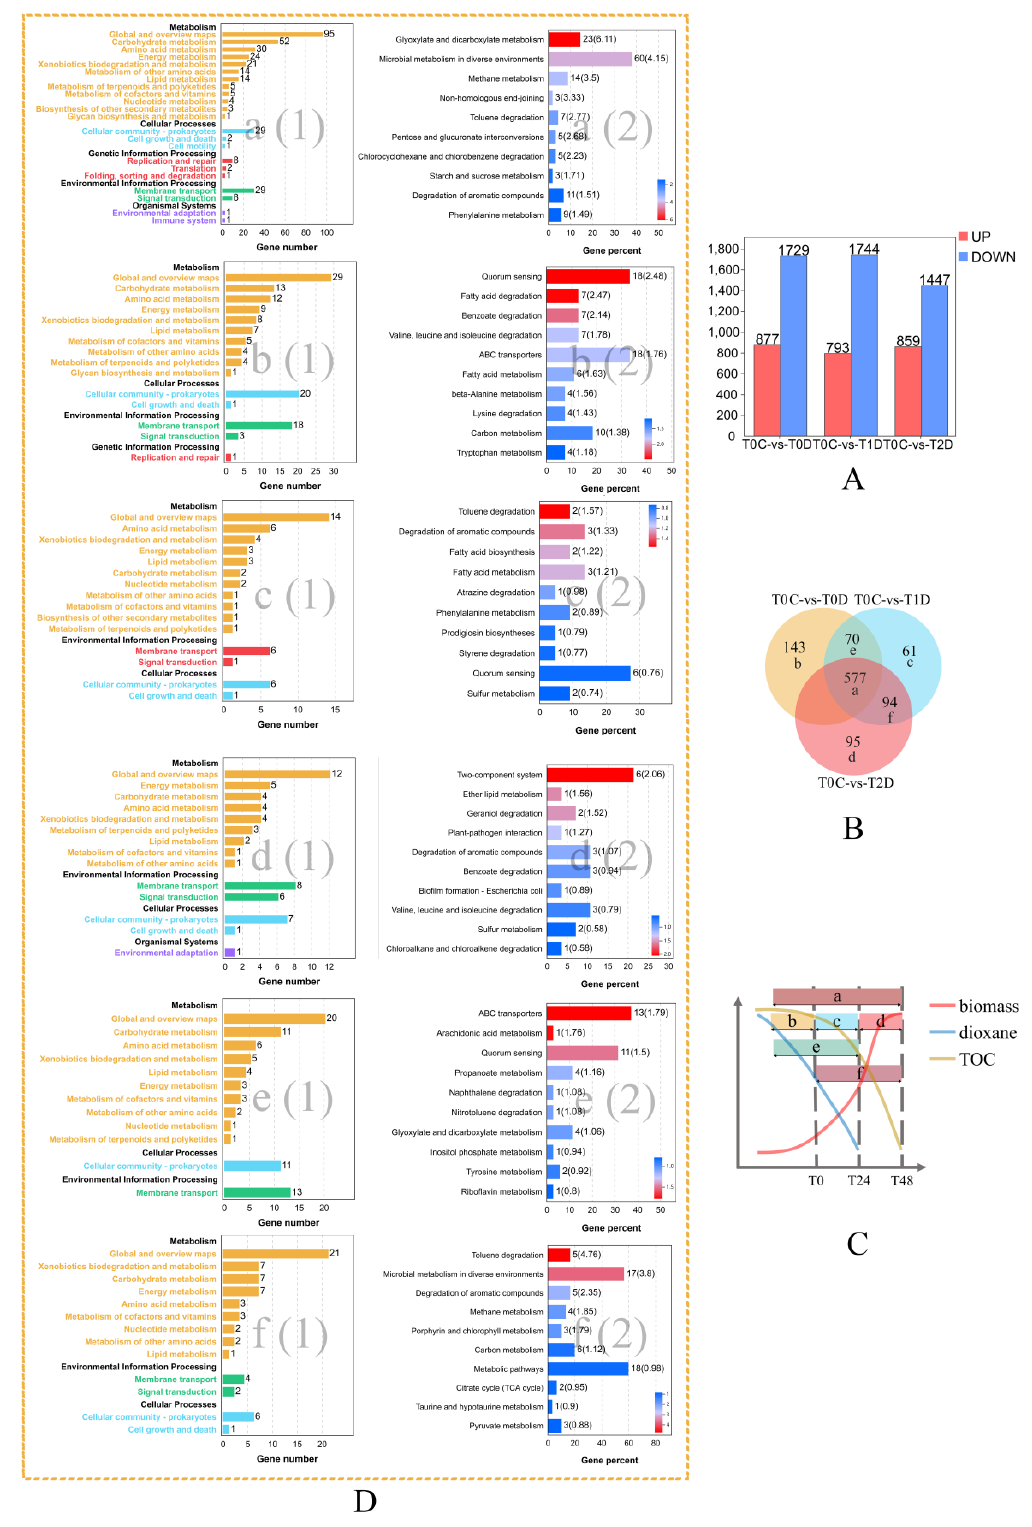
Figure 2. Overview of the dynamic transcriptome during three dioxane degradation stages of the strain YN2: ( A ) number of individual transcripts significantly upregulated or downregulated of each group; ( B ) Venn diagram illustrating the